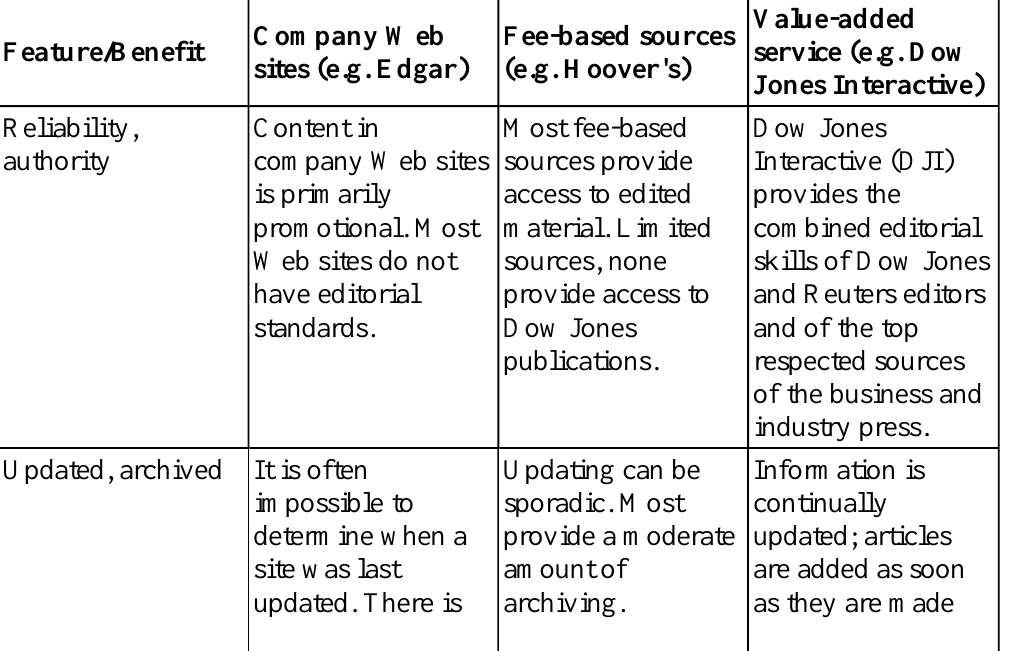
Table 2 Some features and benefits of on-line information resources (Bates